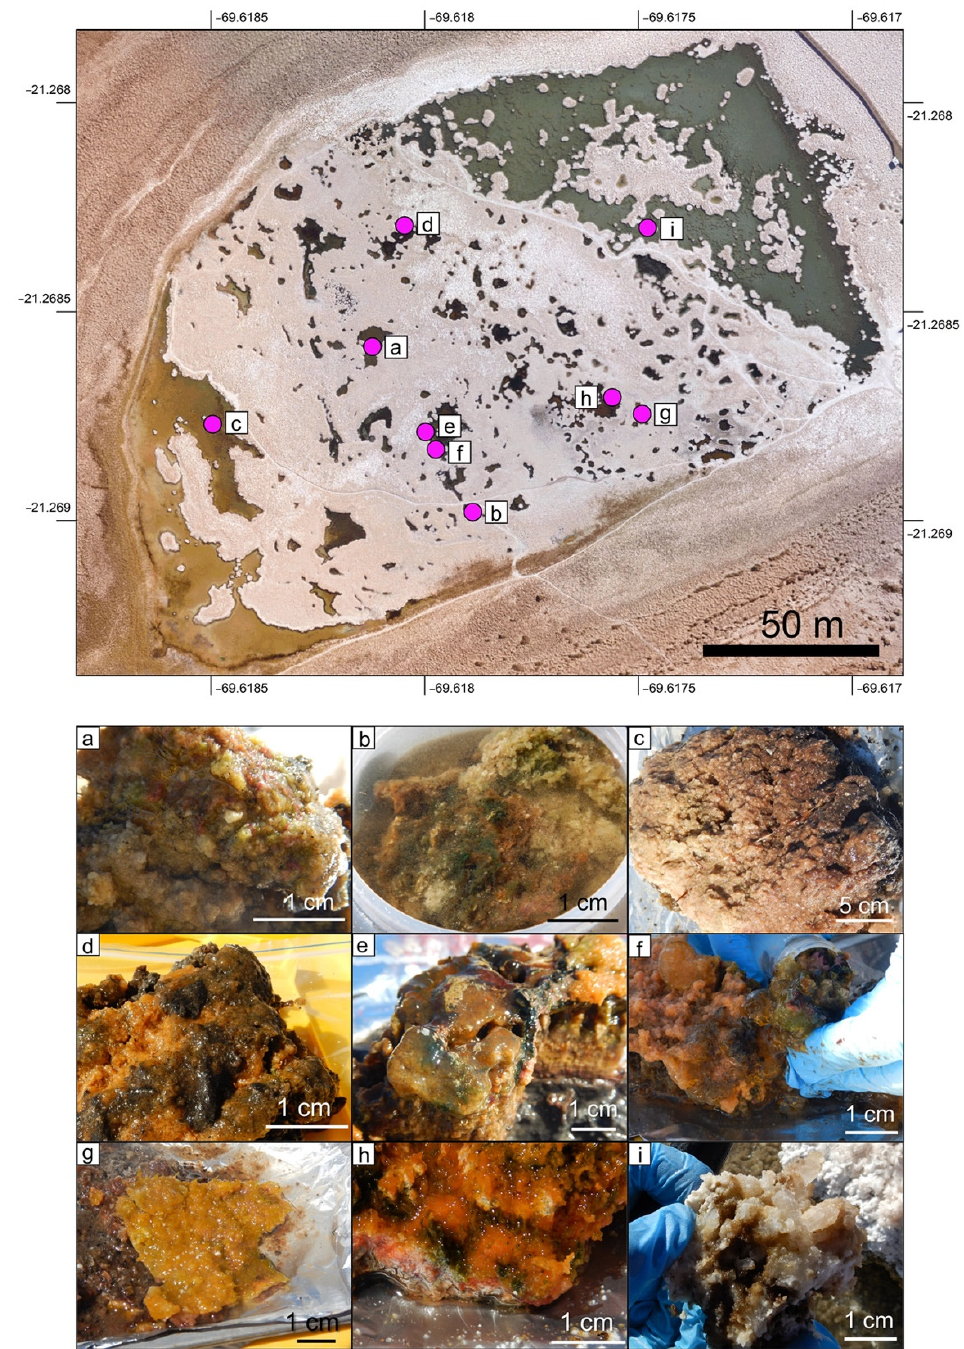
Figure 4. Map showing the location of the collected samples, marked as pink circles, and photographs of corresponding hand samples from March 2019 including ( a ) black domes, ( b ) black semi-cohesive mat, ( c ) floccules, ( d ) network on bulbous mat, ( e ) carpet, ( f ) orange–brown bulbous, ( g ) orange gel mat, ( h ) orange gel mat with black pinnacles, and ( i ) spar.